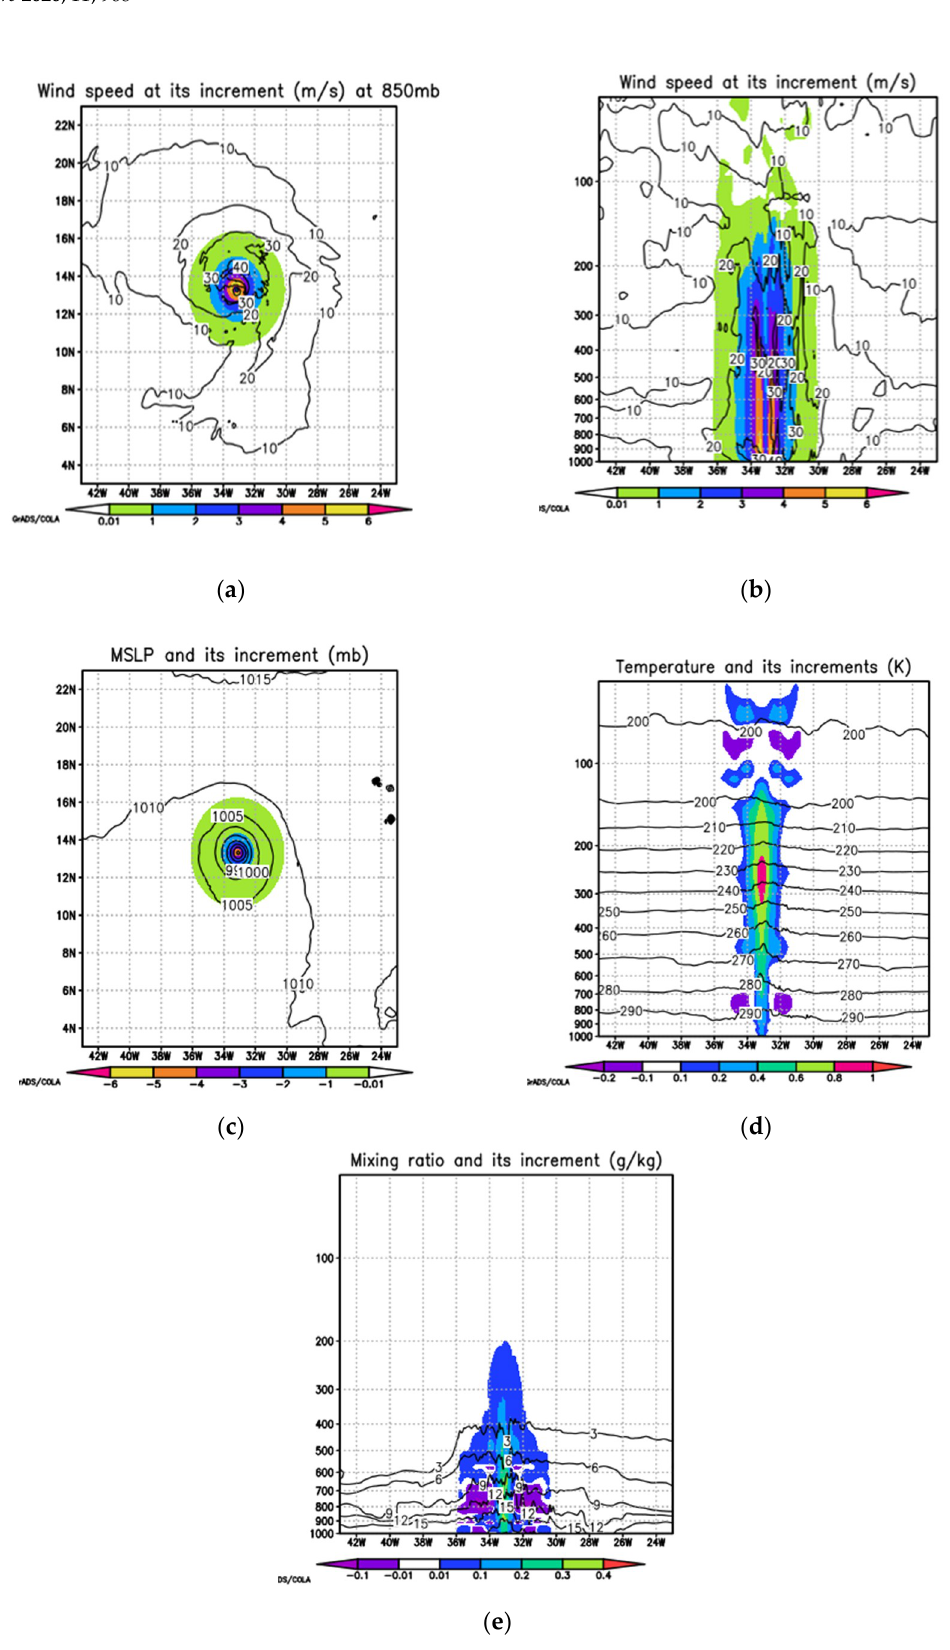
Figure 6. ( a – e ) Same as Figure 2 but after storm intensity corrections in Case II (storm center is located at latitude 13.4° N).